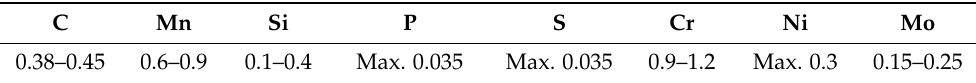
Table 2. Chemical composition of 40HM + QT quenched